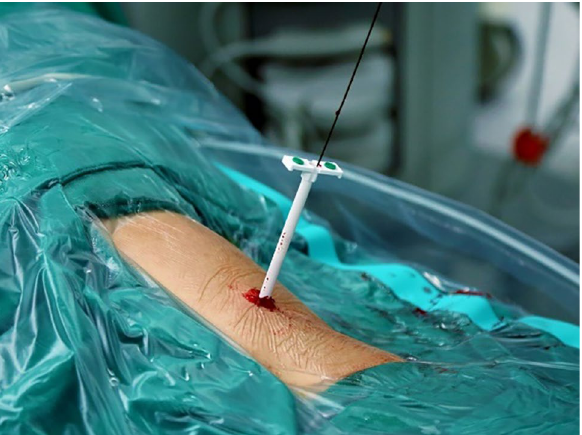
Figure 1. Under the guidance of ultrasound, the puncture needle selected the puncture point between the 11th intercostal or 12th intercostal posterior axillary line and the subscapular angle to puncture into the target calyces and establish the 16F microchannel. (taken by Tianfu Ding).